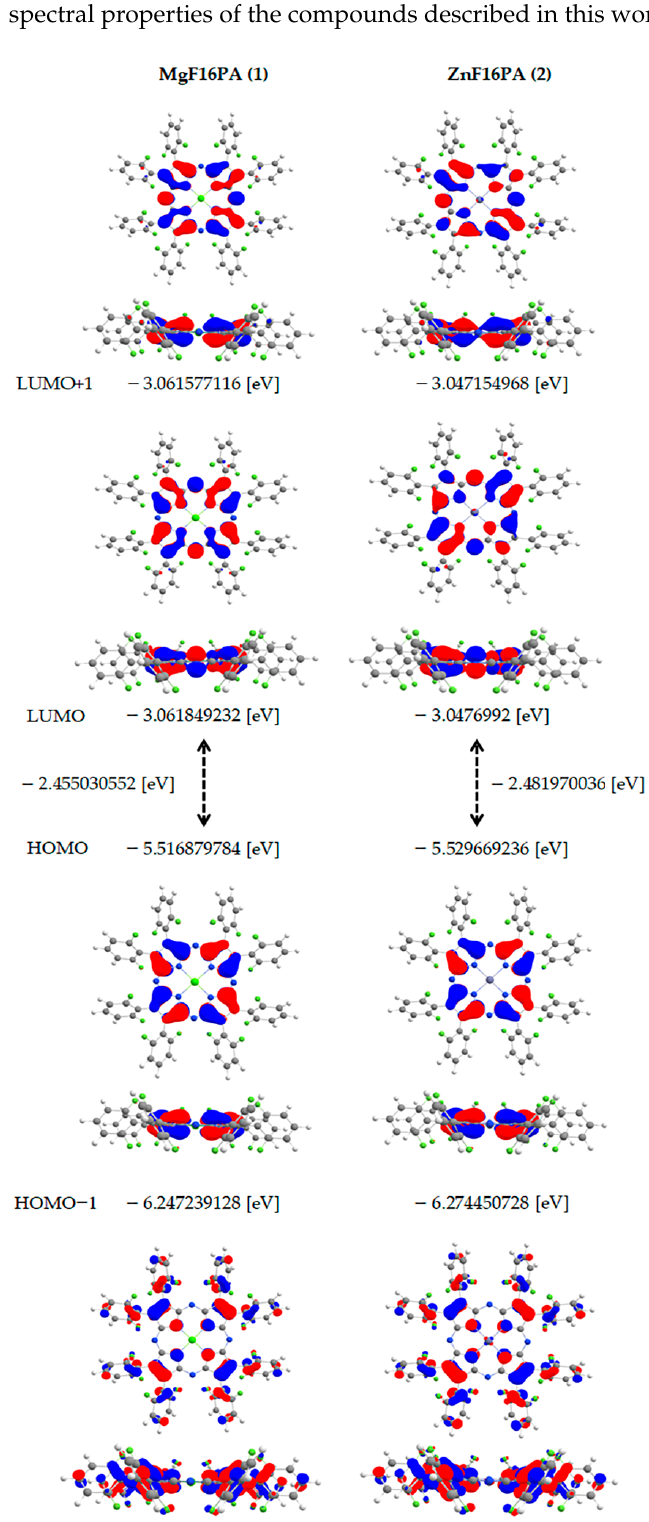
Figure 6. Type and energy of the frontier orbitals of compounds 1 and 2.